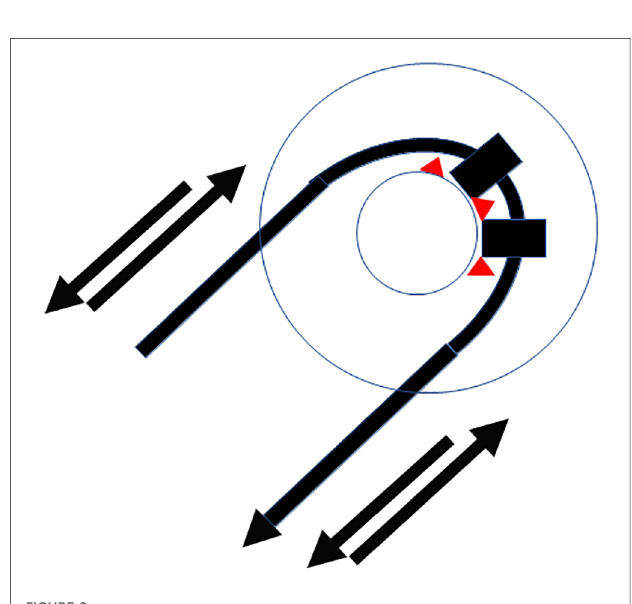
FIGURE 8 Schematic pipe cleaner handling of the device to remove residual tumor parts (red).